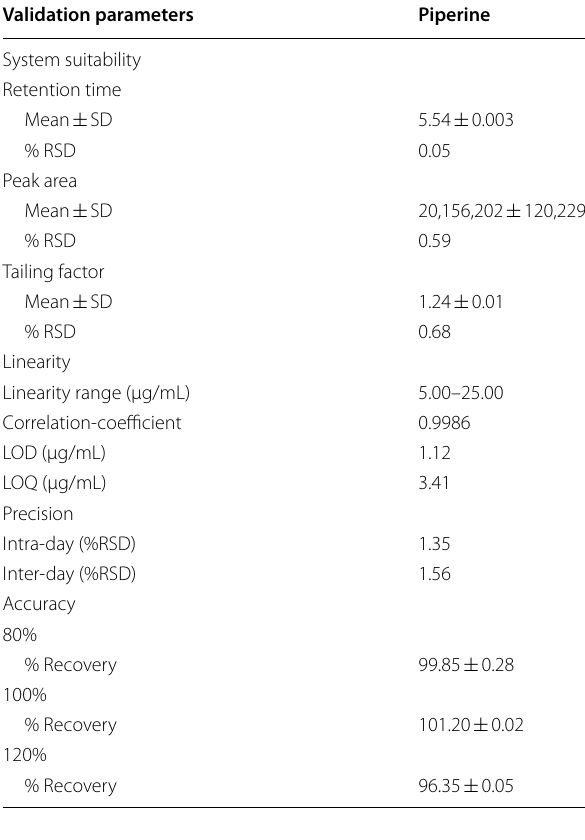
Table 4 Summary of validation parameters